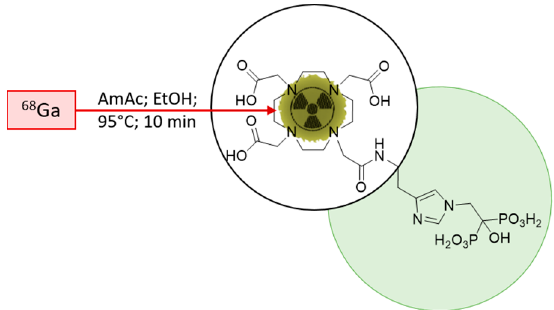
Figure 3. Scheme of the 68 Ga-radiolabelling of DOTA-ZOL. Highlighted in green, the bisphosphonate moiety and, encircled, the chelating moiety.